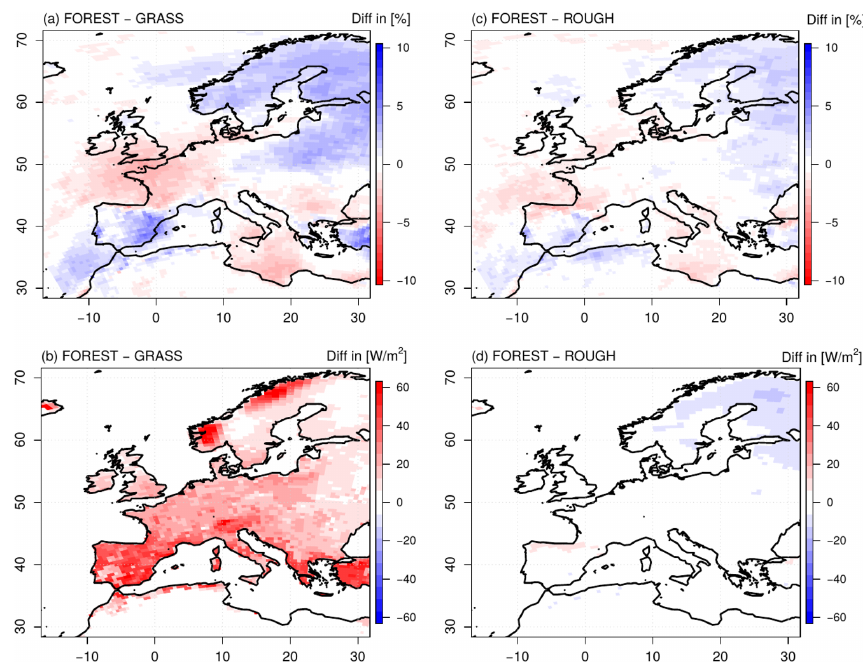
Figure 5. Differences in mean seasonal cloud cover (a, c) and net shortwave radiation (b, d) in summer between the FOREST and the GRASS experiments (a–b) and the FOREST and the ROUGH experiments (c–d) over the simulation period 1986–2015.